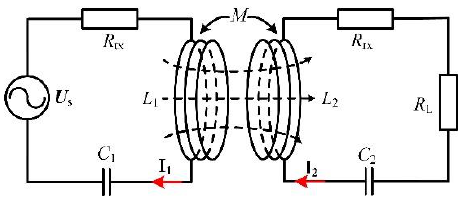
Figure 1. SS resonant topology.